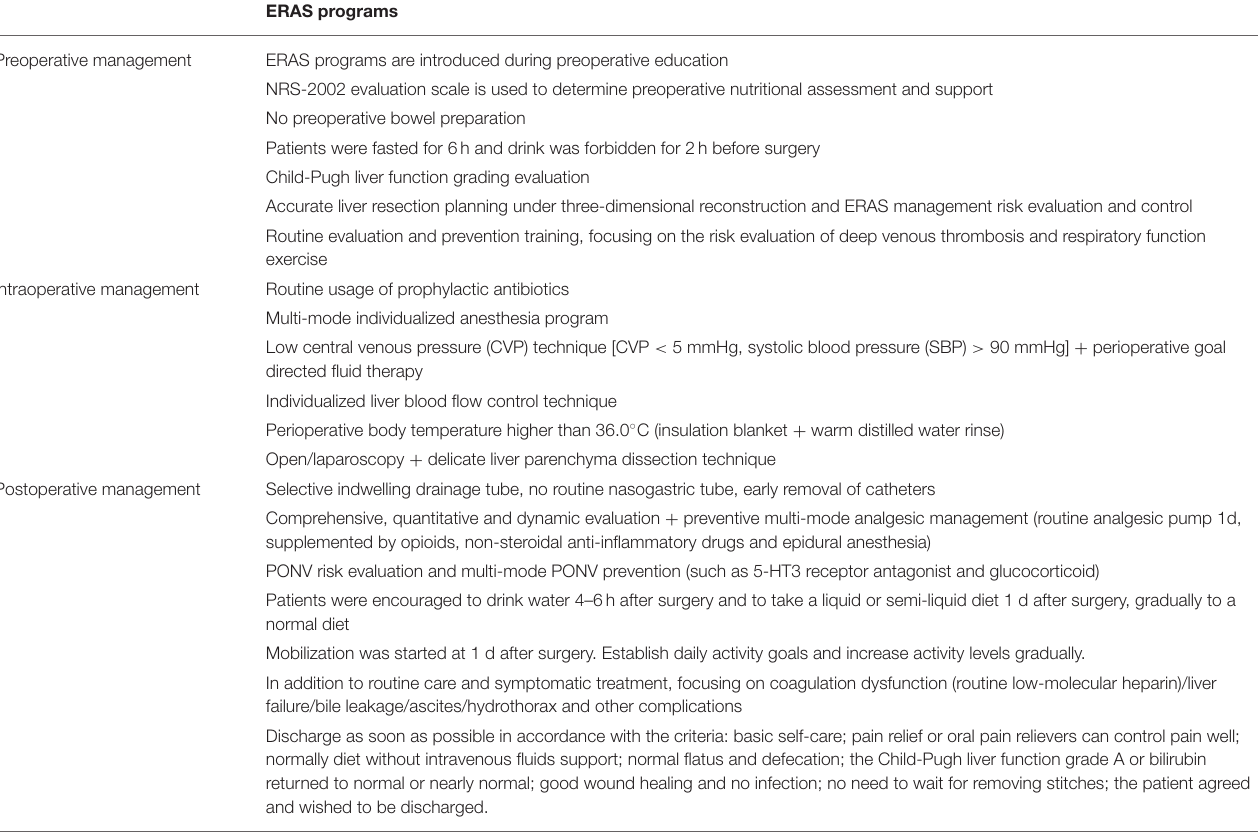
TABLE 1 | Enhanced recovery after surgery (ERAS) programs in our